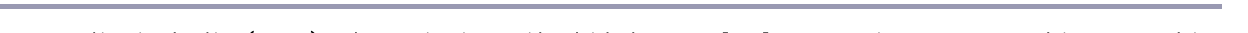
Fig. 1 . Coordination bodies (green) and organizations with which they are closely cooperating. Key: UN-Habitat, UN-Habitat for a Better Life. UNEP, United Nations Environment Program. COPs of the MEAs, Conference of the Parties of the Multilateral Environment Agreement. CSD, Commission on Sustainable Development. CEB, Chief Executives Board. DESA, United Nations Department of Economic and Social Affairs. UNDG, United Nations Development Group. HLCP, High-Level Committee on Programmes. HLCM, High-Level Committee on Management. UN EMG, United Nations Environment Management